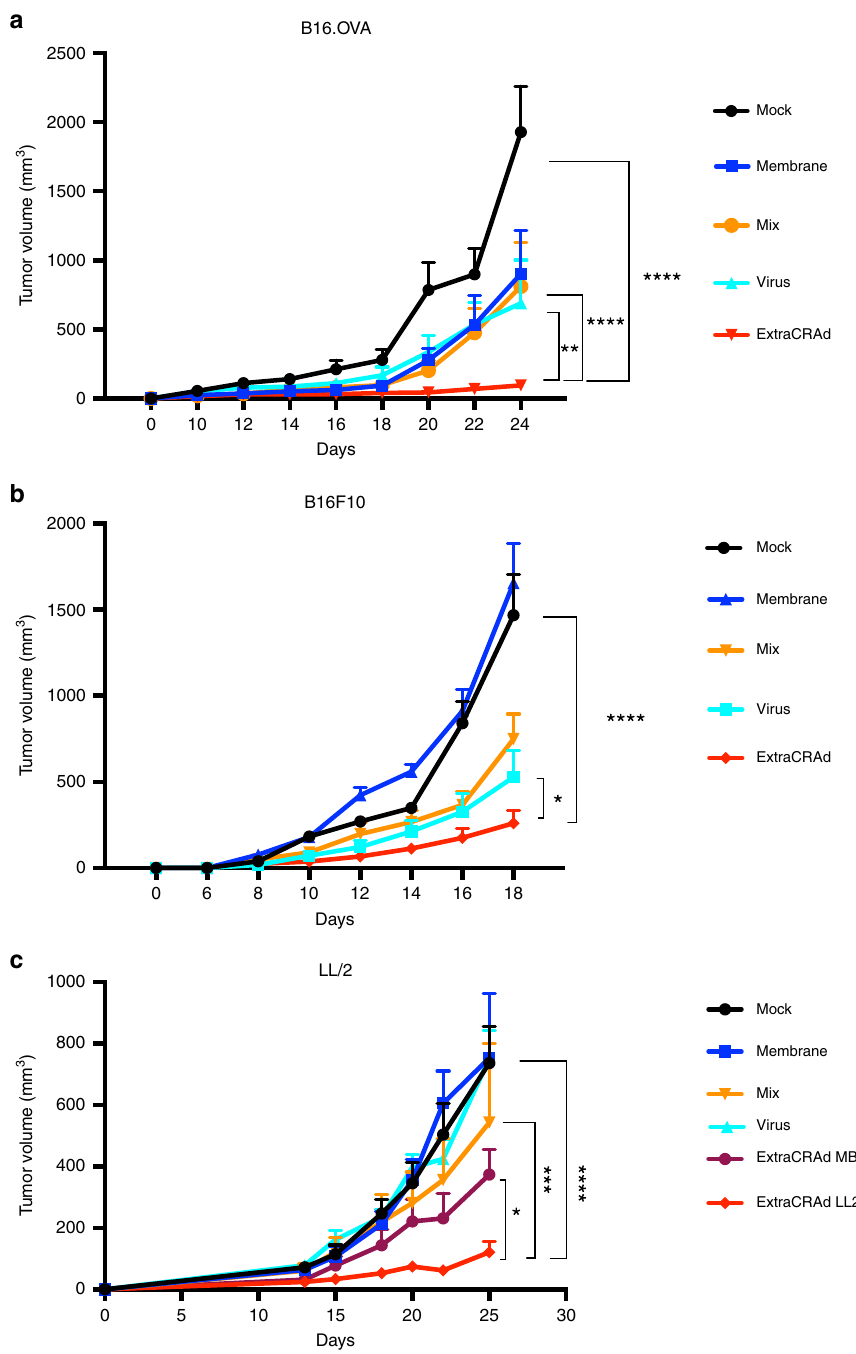
Fig. 4 Ef fi cacy of the treatment with ExtraCRAd in three mouse tumor models. Median tumor growth curves for a B16.OVA, b B16.F10, and c LL/2. In the median curves the data are presented as mean±s.d ( n ≥ 7). Error bars represent s.d. The results were analyzed with a two-way ANOVA, followed by Tukey ’ s ( a , b ) and Dunnet ’ s ( c ) post-test comparison, and the levels of signi fi cance were set at the probabilities of *p <0.05, **p <0.01, ***p <0.001, ****p <0.0001. Mice were injected every second day four times starting at day 8 post-injection for B16.OVA and LL/2 and at day 6 post-injection for